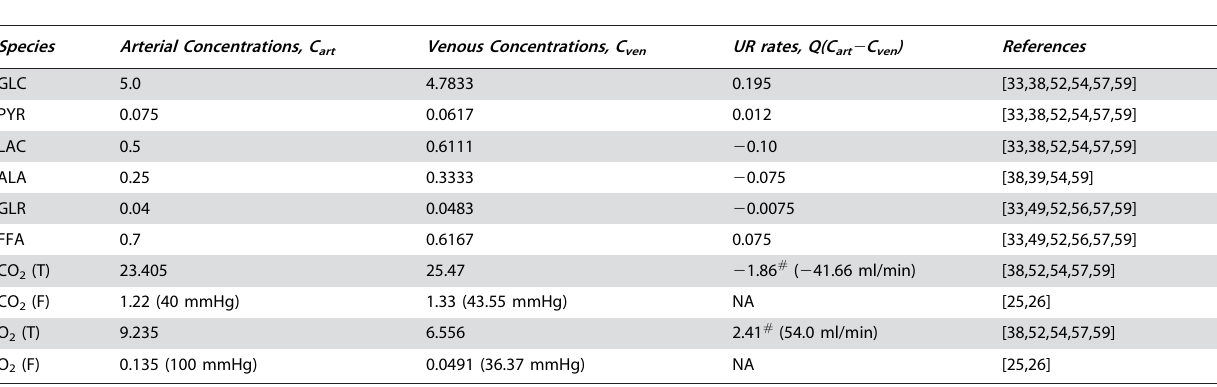
Table 2. Average muscle tissue cells uptake-release rates (mmol/min) and blood species concentrations (mM) at normal, resting steady-state conditions from the